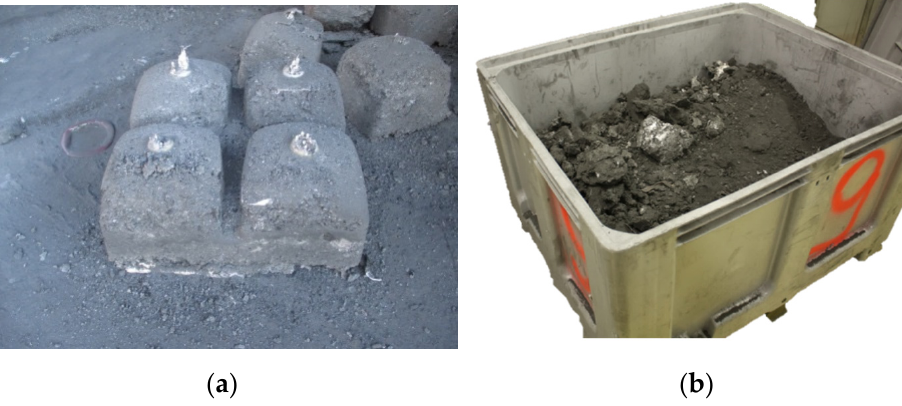
Figure 3. Representation of: ( a ) compacted dross and ( b ) crushed dross pieces.